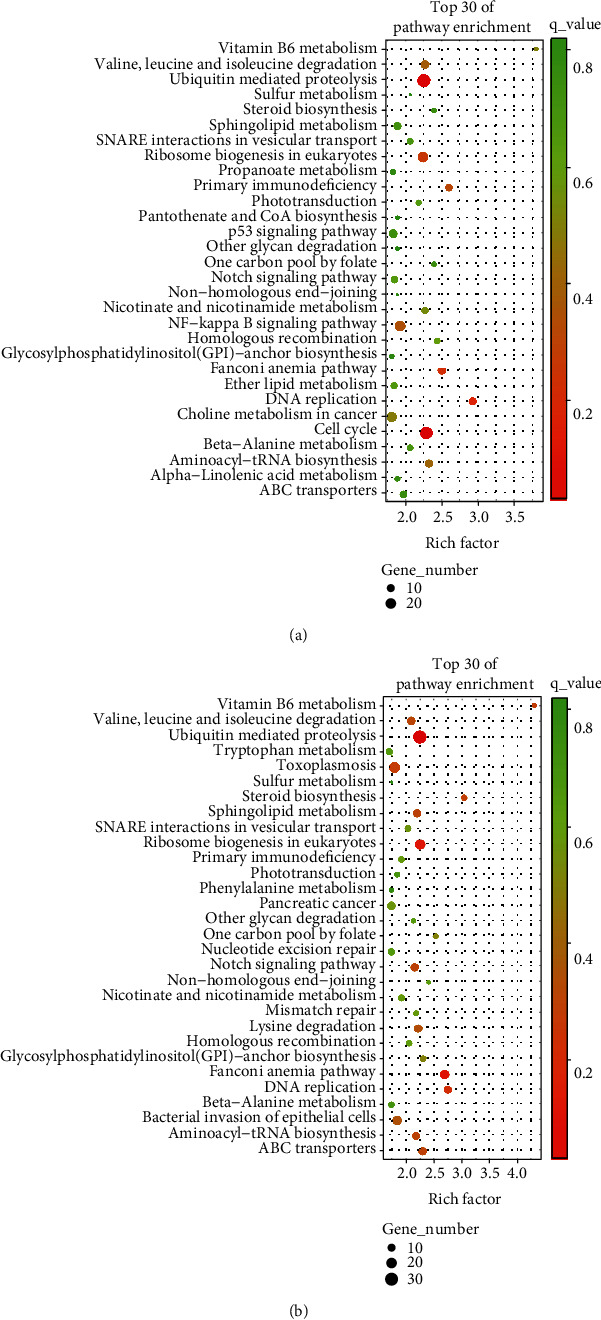
KEEG enrichment scatter plots of differentially expressed lncRNA target genes. (a). Top 30 KEGG pathways for target genes in the shRNA-ANXA7 cell group. (b). Top 30 KEGG pathways for target genes in the shRNA-JNK cell group.